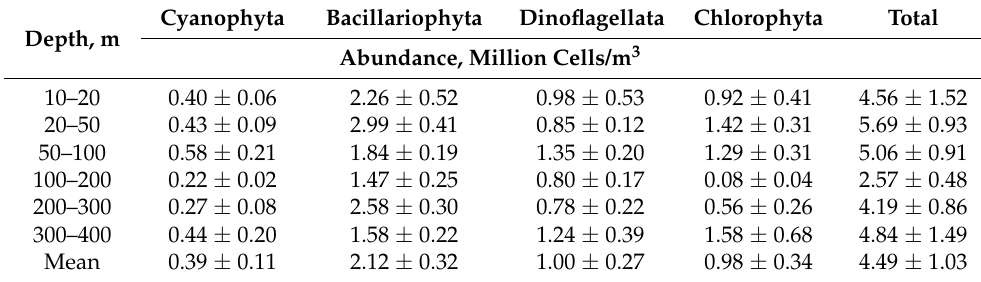
Table 2. Phytoplankton abundance in the eastern part of the Middle Caspian (2016).